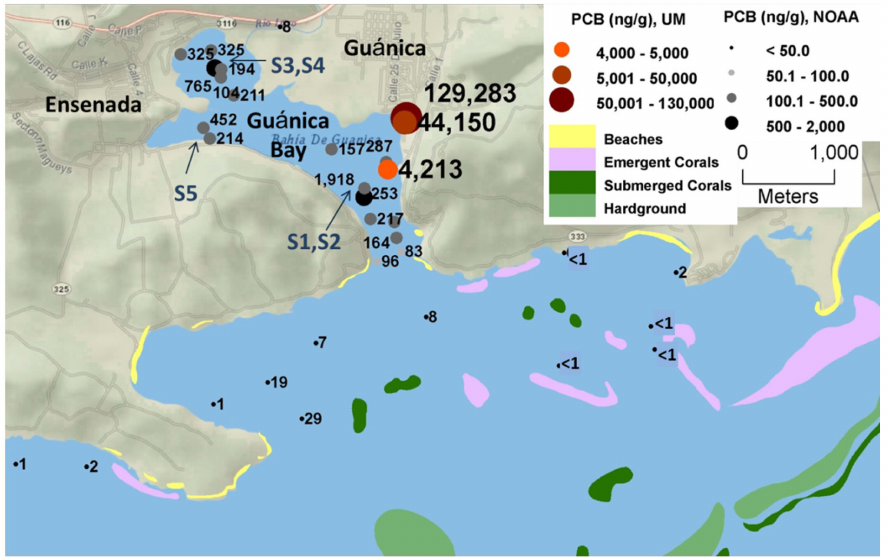
Figure 1. PCB distribution in Guánica Bay. Numbers correspond to PCB concentrations in sediments as documented by NOAA [29,30,32] and Kumar et al. [28]. Arrows represent sampling locations during the Dec. 8, 2012 trip. Yellow areas along the shore correspond to sandy beaches. Reefs are shown in purple (emerged) and dark green (submerged). Light green corresponds to uncolonized hard bottom, which corresponds to areas of coral loss [31]. In the vicinity of the offshore corals, the sediment PCB concentrations are in the single ng/g